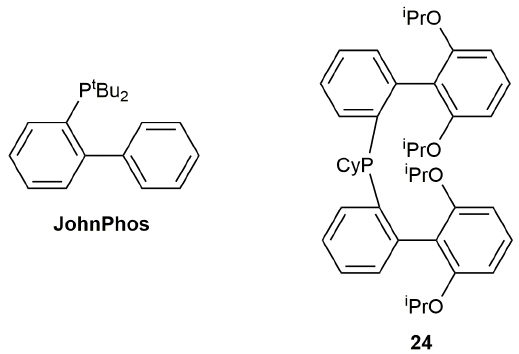
Figure 1. Structure of the o -biphenyl phosphine ligands JohnPhos and 24 .